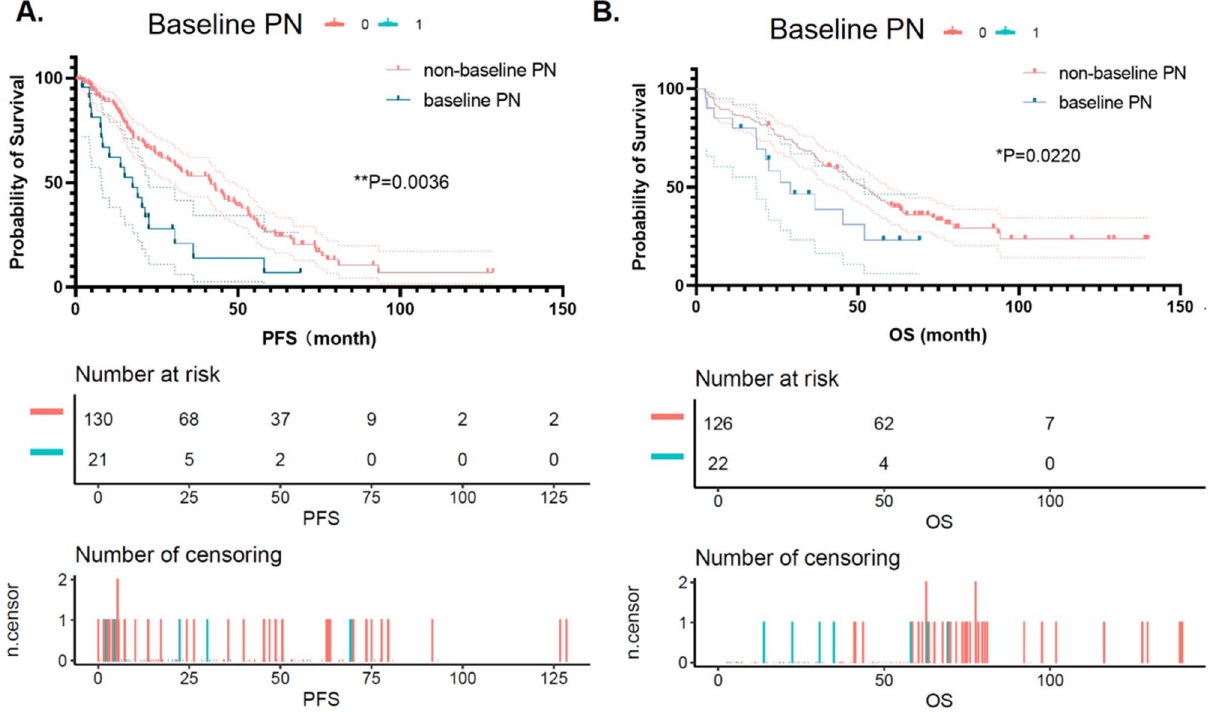
Figure 5. Kaplan–Meier curves (created by Empower Stats and R software, www. empow ersta ts. com; http:// www.R- proje ct) of progression-free survival (PFS) and overall survival (OS) according to baseline PN. ( A ) MM patients with baseline PN had poorer PFS than with non-baseline PN ( p = 0.0036). ( B ) Compared to MM patients with baseline PN, MM patients with non-baseline PN had better OS ( p = 0.0220). MM